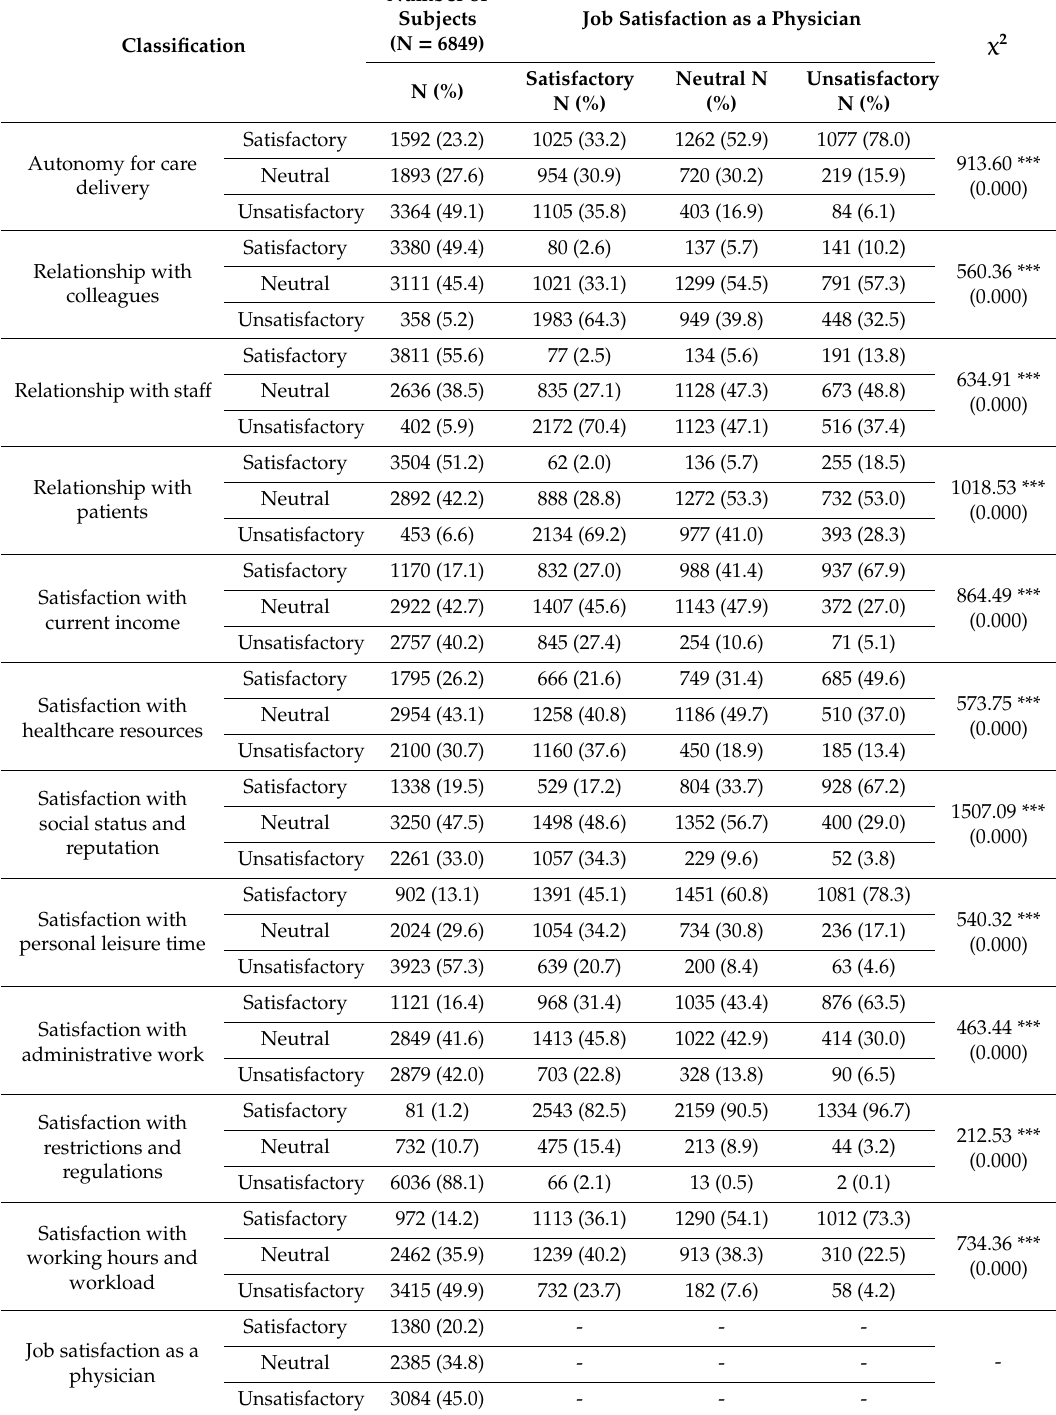
Table 3. The distribution and Chi-square of medical environment